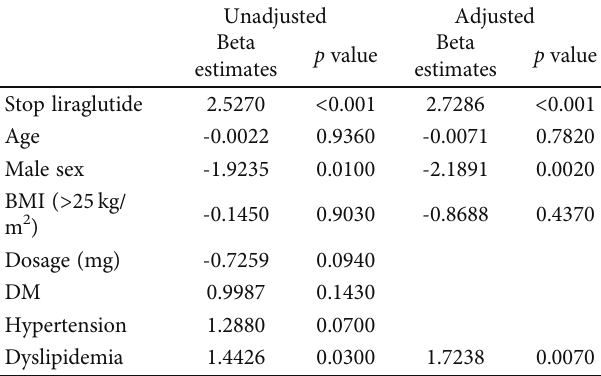
Table 2: Regression model for weight at 3